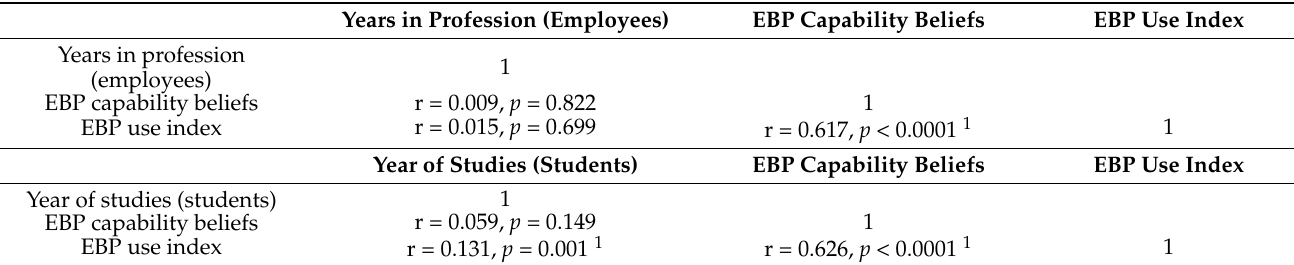
We examined the correlation between the EBP capability beliefs index, EBP use index, and seniority level (Table 3). We found a strong relationship between the two EBP indices for both professional groups (r > 0.6, p < 0.001), whereas the number of years in profession did not correlate with the indices in the employees, but the year of studies (students) showed a negligible, hence statistically significant correlation with the EBP use index (r = 0.1, p < 0.001). Table 3. Correlations between the evidence-based practice (EBP) capability beliefs index, evidence-based practice use index and years in profession (employees) and year of studies